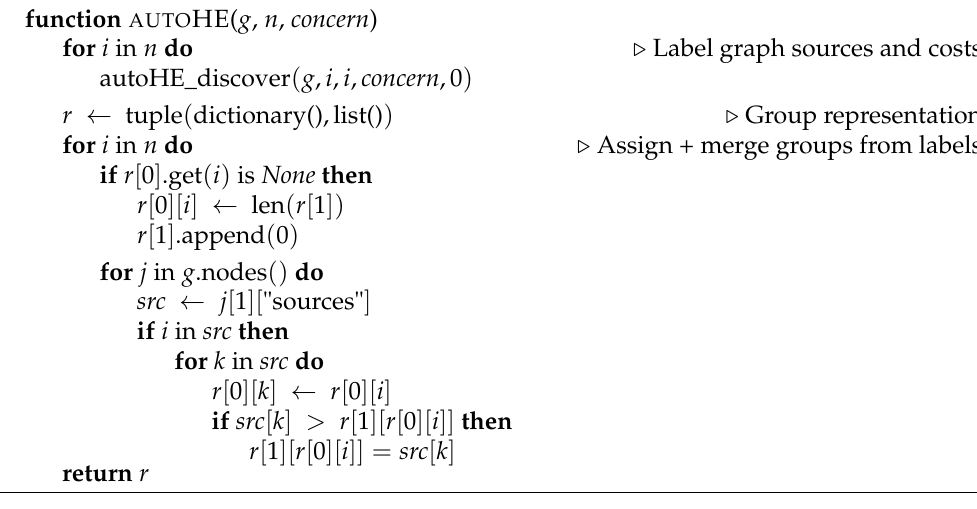
Algorithm 6 Automatic FHE parameterisation by source and cost discovery over multi- directed graphs.